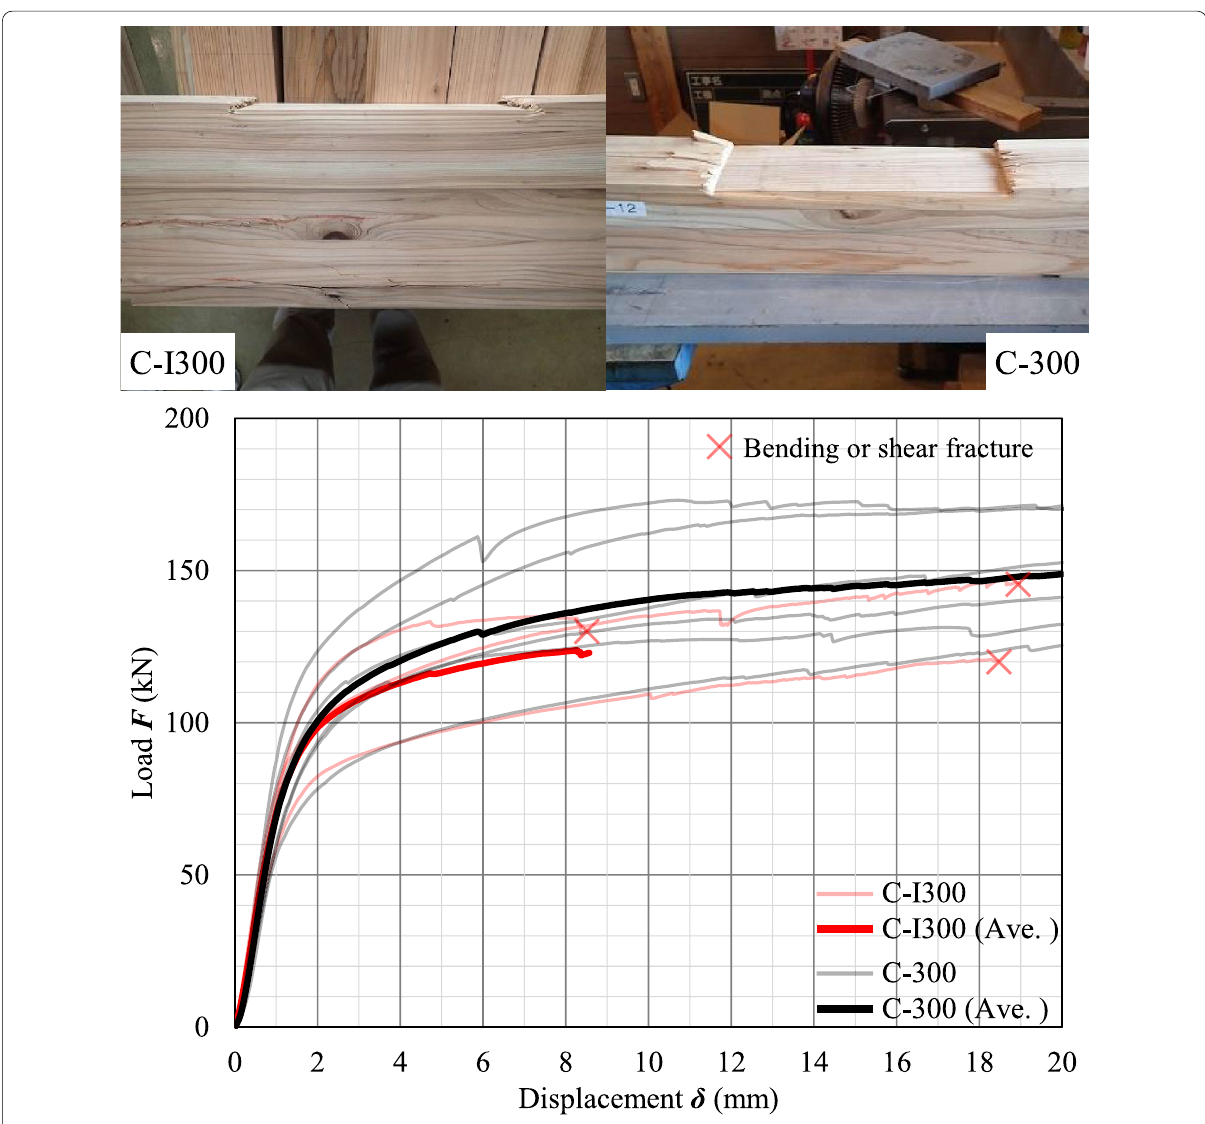
Fig. 22 Relationship between the force point load F and displacement δ of C-I300 and